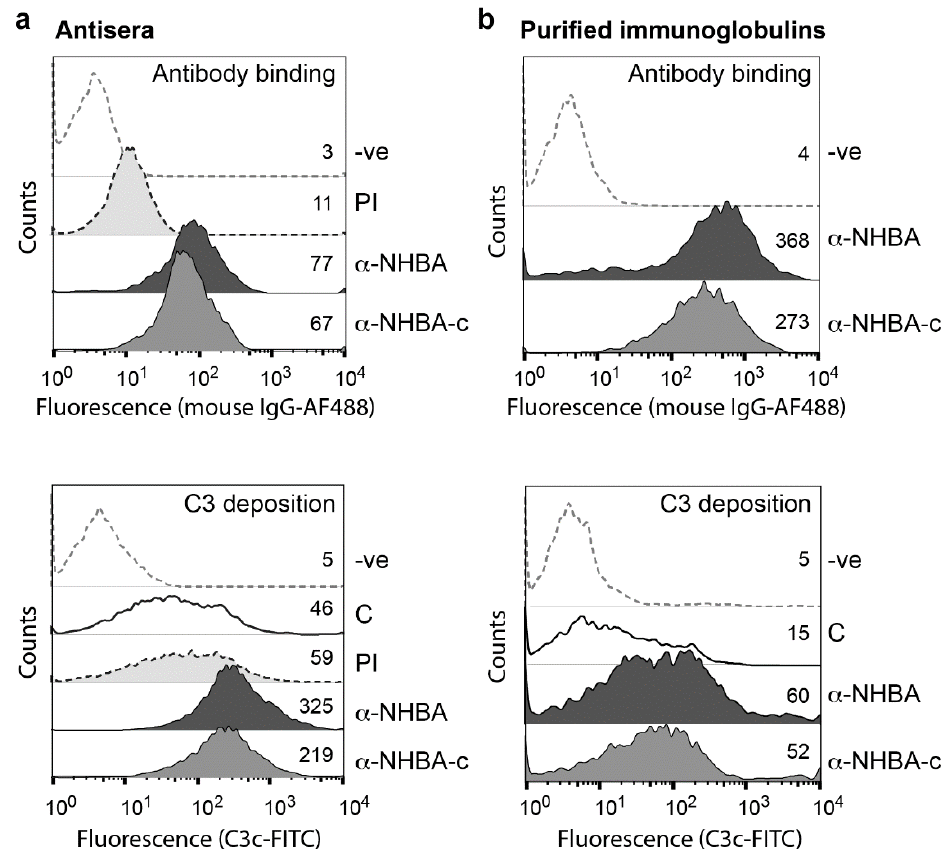
Figure 3. Antibody binding and complement activation as measured by fragment deposition on N. gonorrhoeae. Flow cytometry of antibody binding and antibody-mediated C3-fragment deposition on the surface of N. gonorrhoeae 1291, in the presence of (a) polyclonal antisera or (b) purified immunoglobulins from mice immunised with either NHBA-Freund’s or NHBA-c-Freund’s. Values represent geometric mean fluorescence of antibody binding to N. gonorrhoeae cells and C3-fragment deposition. Secondary antibody only (-ve), pre-immune (PI) mouse sera and complement only (C) controls are included. Sera and purified immunoglobulins used are from a pool of mouse sera from five mice per group. Experiments were done at least three times and a representative result is shown. In all panels, the geometric mean fluorescence of α -NHBA and α -NHBA-c are significantly above the PI and C controls (Student’s t -test p < 0.001).